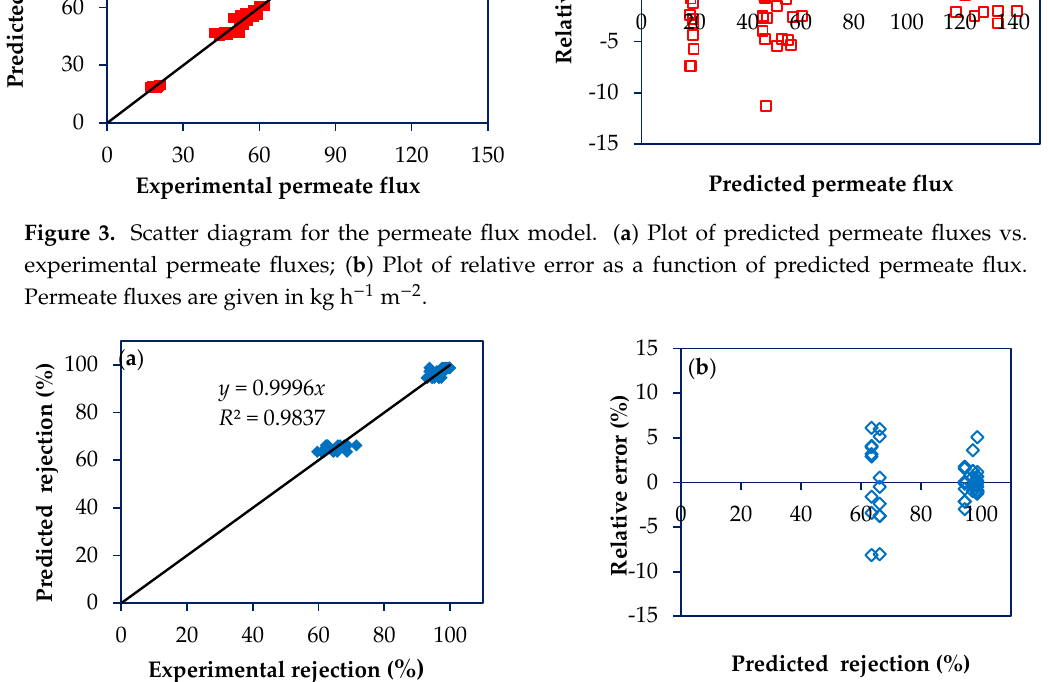
Figure 4. Scatter diagram for the rejection model. ( a ) Plot of predicted rejections vs. experimental rejections; ( b ) Plot of relative error as a function of predicted rejection.